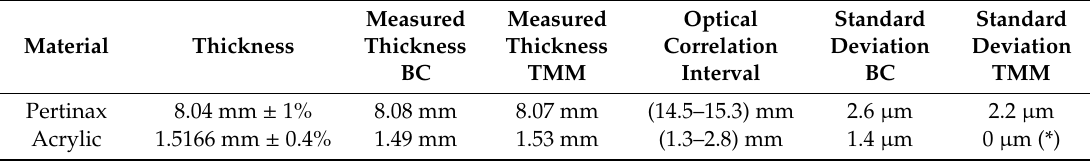
Table 2. Parameters for the evaluation of the composite layer system